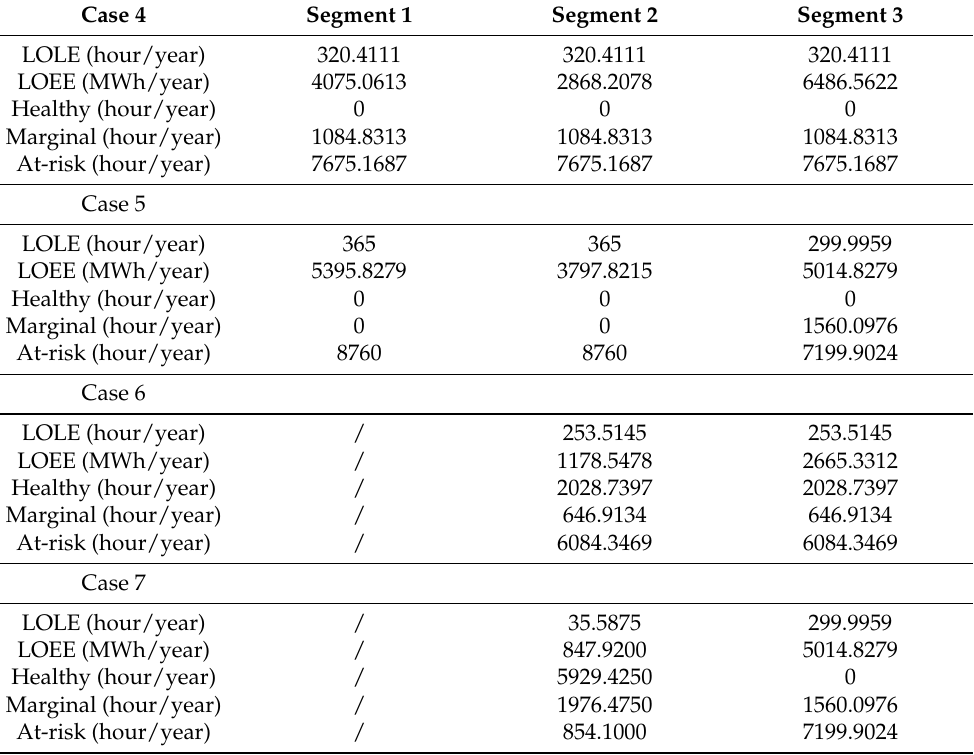
Table 3. Reliability